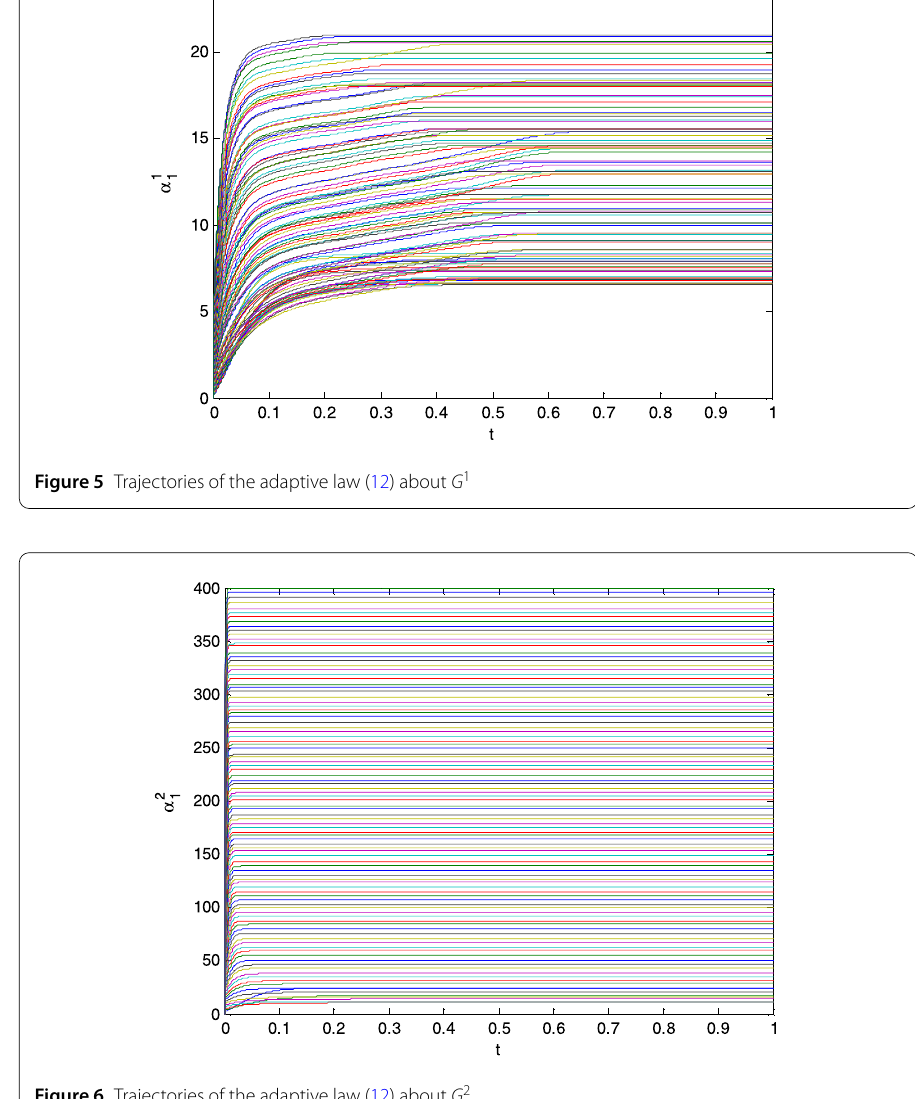
Figure 6 Trajectories of the adaptive law (12) about G